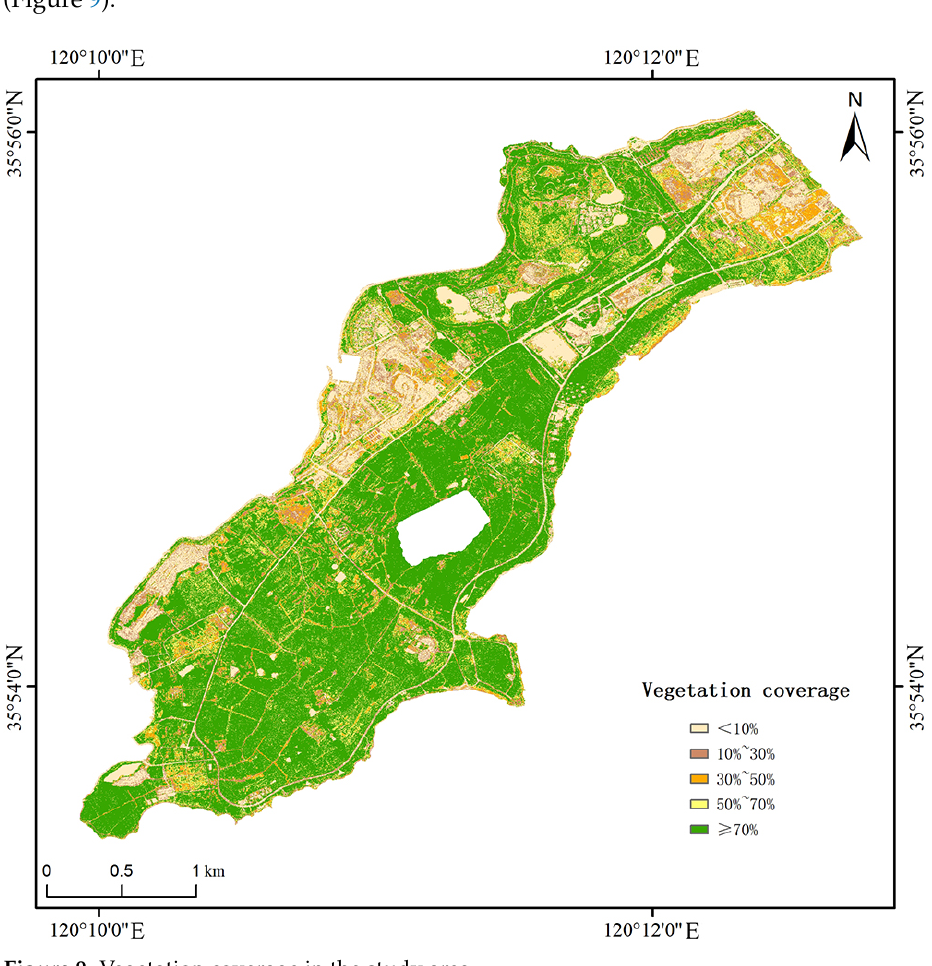
Figure 9. Vegetation coverage in the study